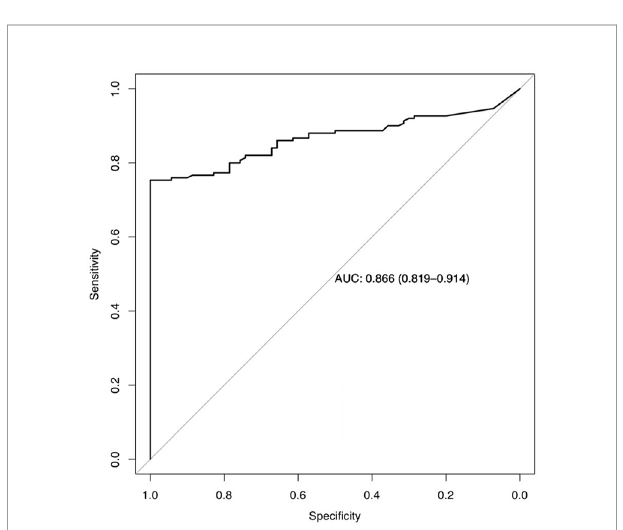
FIGURE 6 | Area under the Receiver Operating Characteristic curve (AUC) and statistical data, in parentheses 95% con fi dence interval for the random forest model based on k el und